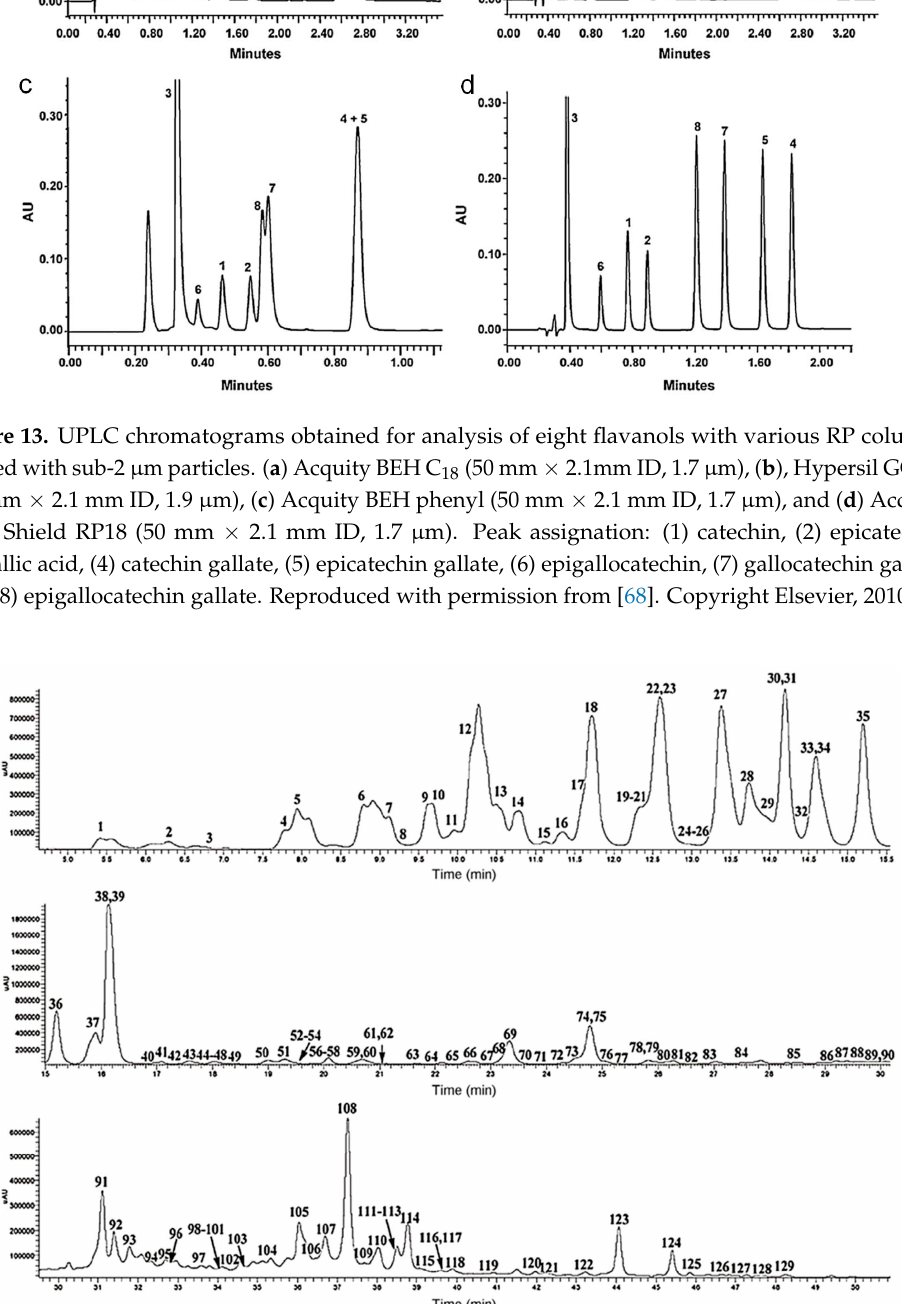
Figure 14. UPLC-DAD chromatogram at 330 nm for determination of flavonol glycosides and hydroxycinnamic acid derivatives of red mustard greens extract. Reproduced with permission from [67]. Copyright American Chemical Society, 2011.